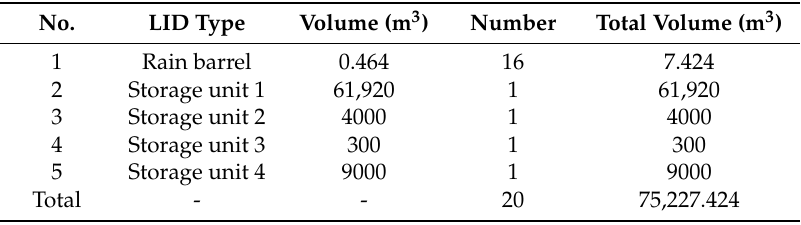
Table 8. Area of different LID types.